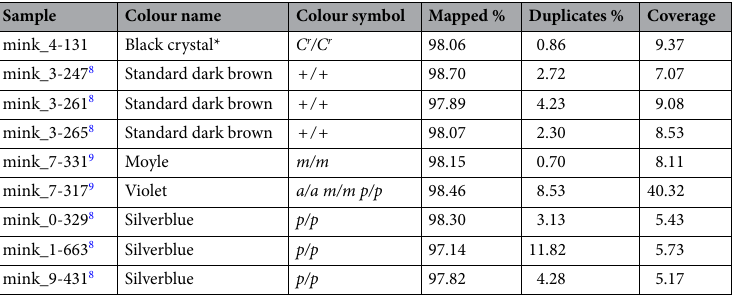
Table 1. Results of sequencing of American mink genomes. Statistics were calculated using samtools 11 and Picard software. The American mink genome (NNQGG.v01) was used as a reference. *Completely white animal, with no hearing defects.